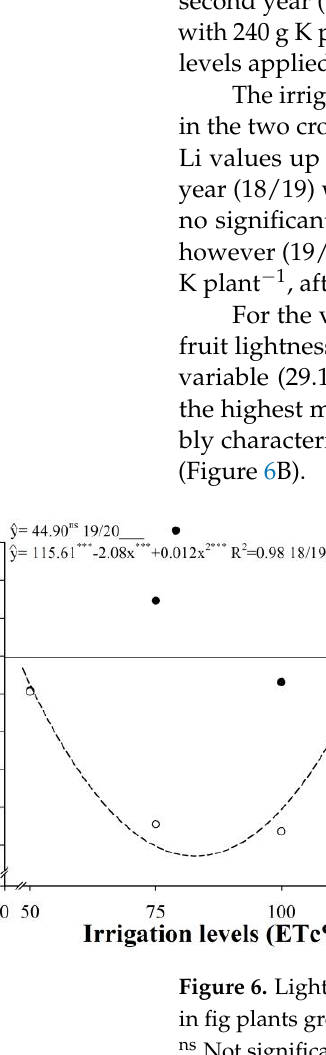
Figure 7. Firmness of fig fruits produced in the 2018/2019 ( A ) and 2019/2020 ( B ) crop years as a function of irrigation levels and potassium doses under semiarid conditions in the 2018/2019 and 2019/2020 crop years. * Significant ( p < 0.05); ** Significant ( p < 0.01); *** Significant ( p < 0.001); ns Not significant ( p > 0.05). In the second year (19/20), the increase in the irrigation levels in the plants fertilized with 60 and 240 g K plant −1 caused reductions in FF up to the Li of 95.51% (2.82 N) and 92.50% (3.58 N), respectively, with further increases in FF occurring at higher Li values (Figure 7B). For the plants without potassium application (0 g plant −1 ), there was a grow- ing linear response of FF with the increase in the Li (ETc%). This response can be associ- ated with the organic fertilization provided to the plants in both cycles (18/19 and 19/20). For the plants fertilized with 120 g K plant −1 , there were maximum increases in FF (4.36 N) by applying irrigation levels up to 103.75% ETc, with reductions in FF at higher Li values (Figure 7B).